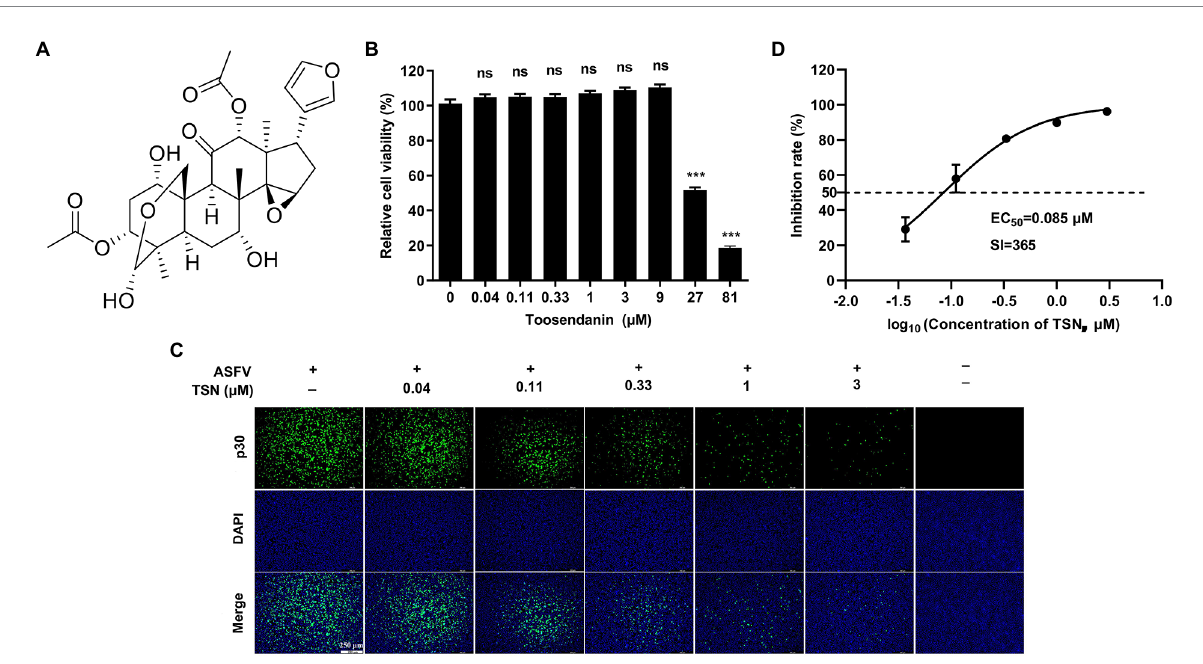
FIGURE 1 TSN inhibits ASFV infection in PAMs with no cytotoxicity. (A) Chemical structure of TSN. (B) Cytotoxicity of TSN on PAMs was analyzed by MTT assay as described in the Methods. (C) Antiviral activity of TSN against ASFV in PAMs was determined by IFA. Briefly, PAMs were seeded into 24-well plates ， infected with ASFV (0.014 MOI) for 2 h and then incubated with maintenance medium containing indicated concentrations of TSN. ASFV was detected by immunofluorescence using a mouse anti-p30 antibody at 48 hpi. The nuclei were counter-stained with DAPI (blue). (D) EC 50 of TSN in ASFV-infected PAMs was calculated as described in the Methods. *** denotes p < 0.001; ns denotes no significant